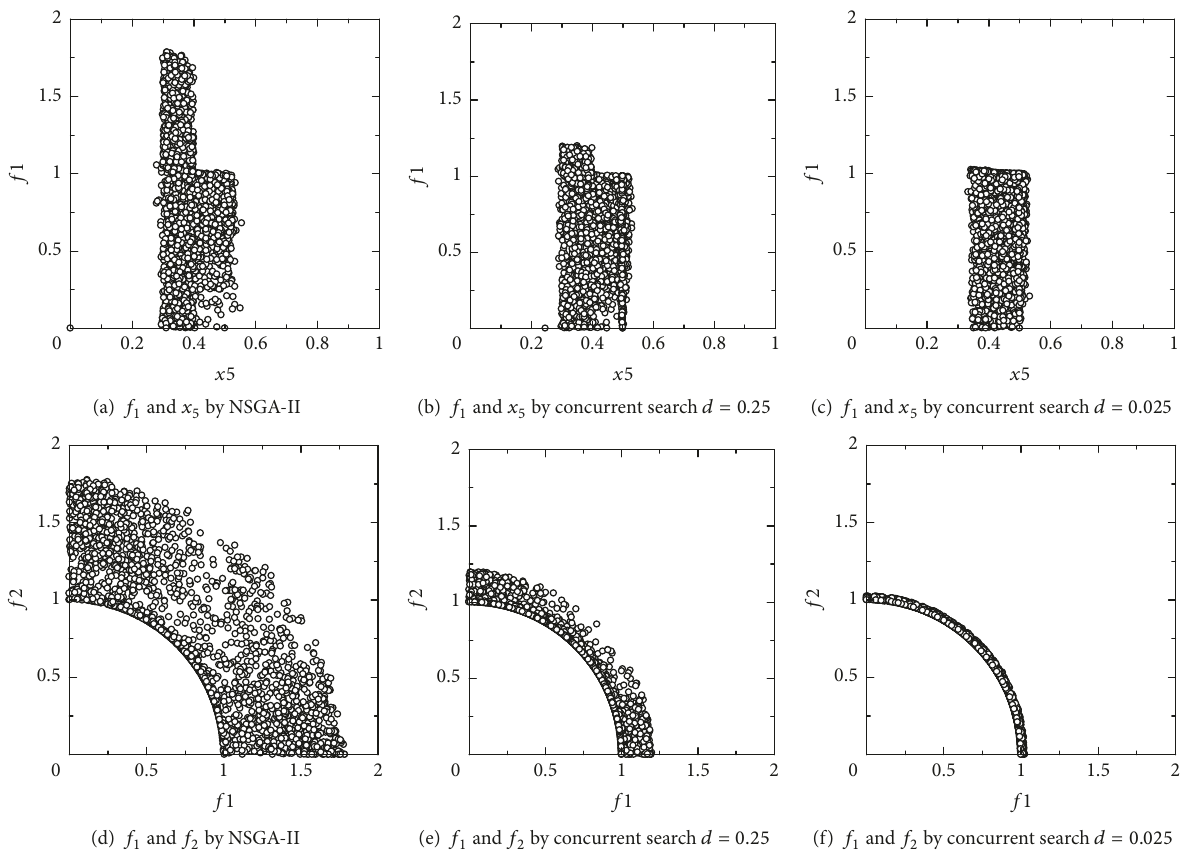
Figure 10: Solutions by NSGA-II and proposed method searching concurrently with two populations in the original and extended space on problem. DTLZ2, 𝑚 = 2 original objectives, 𝑀 = 4 objectives in the extended space, and 𝑛 = 5